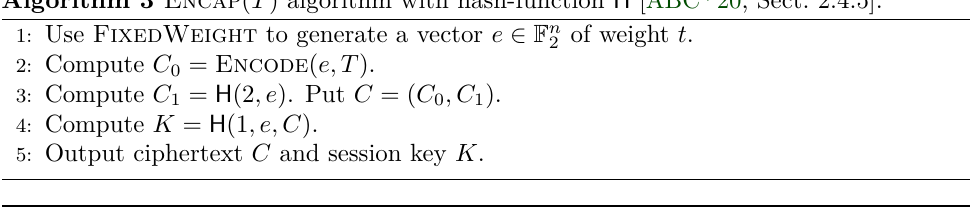
Algorithm 4 FixedWeight algorithm [ABC + 20, Sect. 2.4.4].